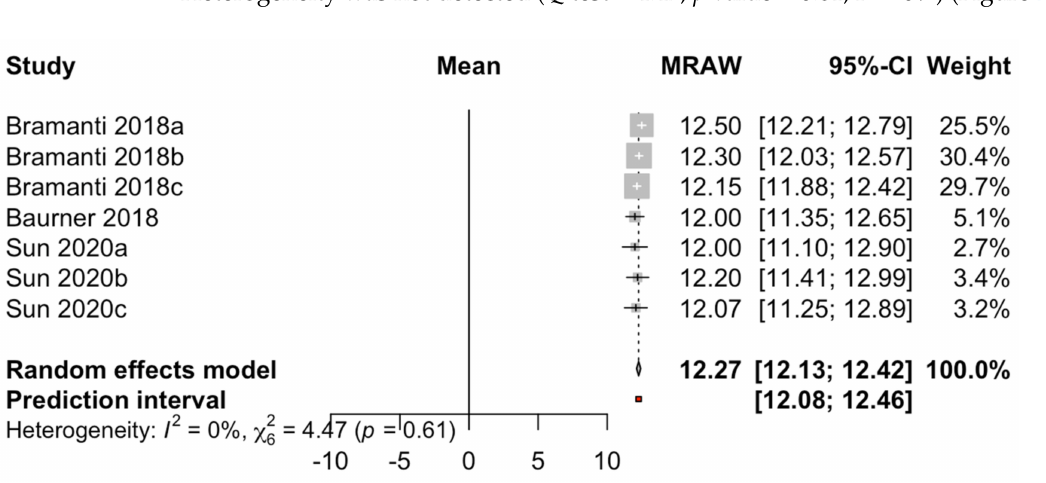
Figure 7. Forest plot of the mean PES of immediate dental implant placement using the socket-shield technique in the esthetic